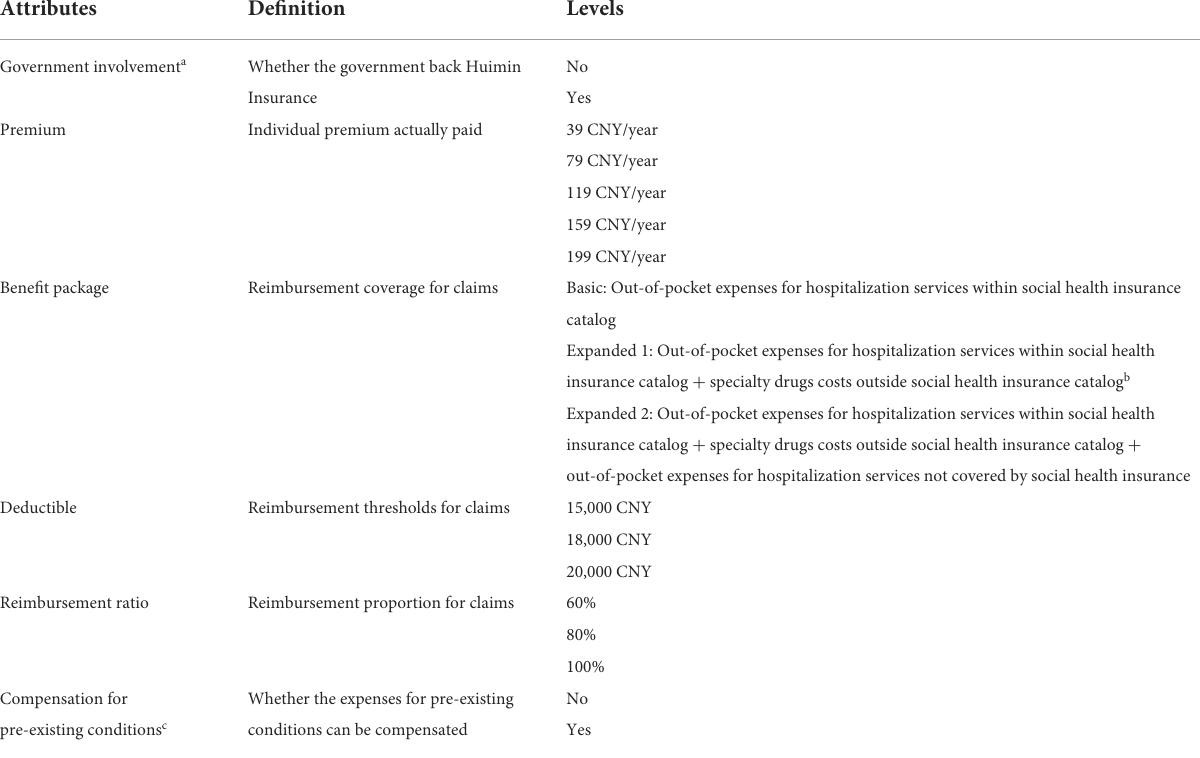
TABLE 1 Characteristics of attributes and attribute